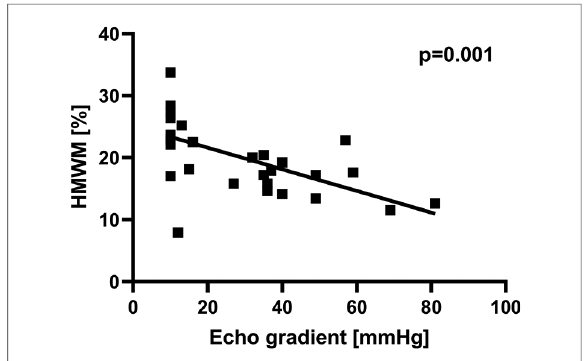
FIGURE 2 HMWM decrease was related signi fi cantly to peak systolic echocardiographic gradients.